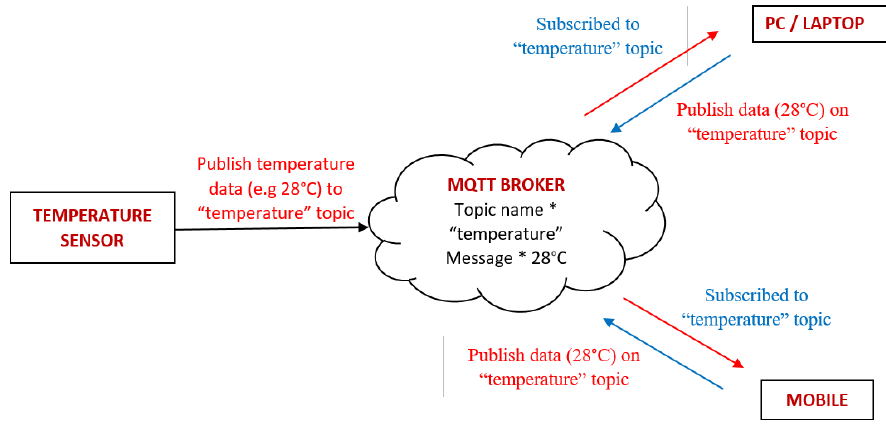
Figure 5. Workflow of MQTT for sensor data [14].